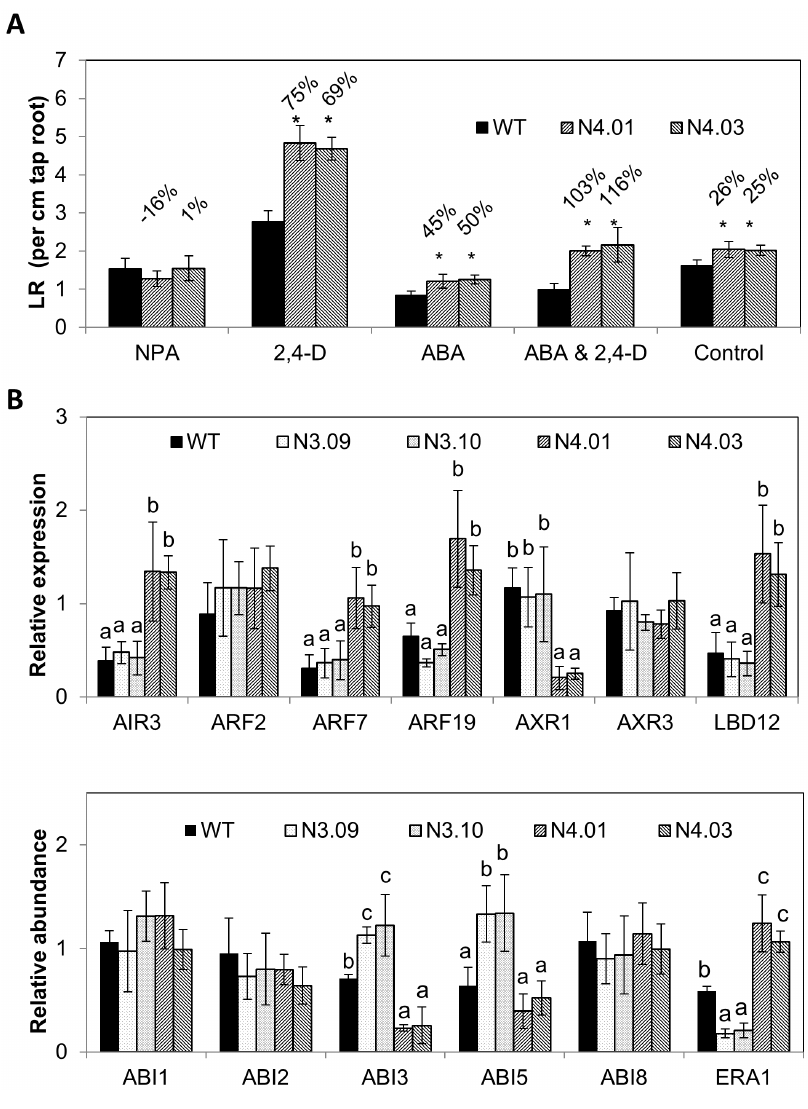
Figure 7. Role of GmNAC004 in regulation of lateral root density of transgenic Arabidopsis plants. (A) Transgenic Arabidopsis overexpressing GmNAC004 in response to ABA and 2,4-D treatments. Four-day-old seedlings of WT and GmNAC004 transgenic plants (T4 generation) were exposed to 5 m M ABA, 20 nM 2,4-D, 2 m M NPA or their combinations for 7 days. Control treatment was not treated with hormones. Error bars are the standard errors of the means from six replications. Asterisks denote significant differences at 95% between the WT and transgenic plants. (B) Expression of representative ABA and auxin signaling genes in transgenic GmNAC003 and GmNAC004 Arabidopsis plants. Duncan multiple-mean comparisons were used and different letters indicates differences of the means.